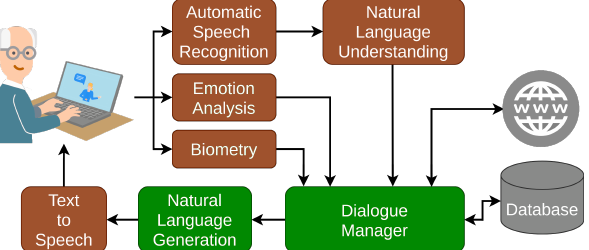
Figure 1. EMPATHIC system schema. The components we analyse here are highlighted in